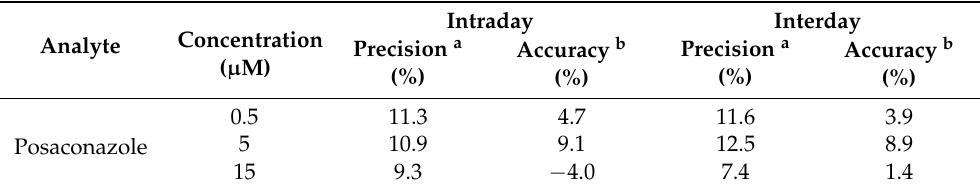
Table 1. Intraday and interday precision and accuracy for EME-MALDI/MS analysis of posaconazole ( n = 5).